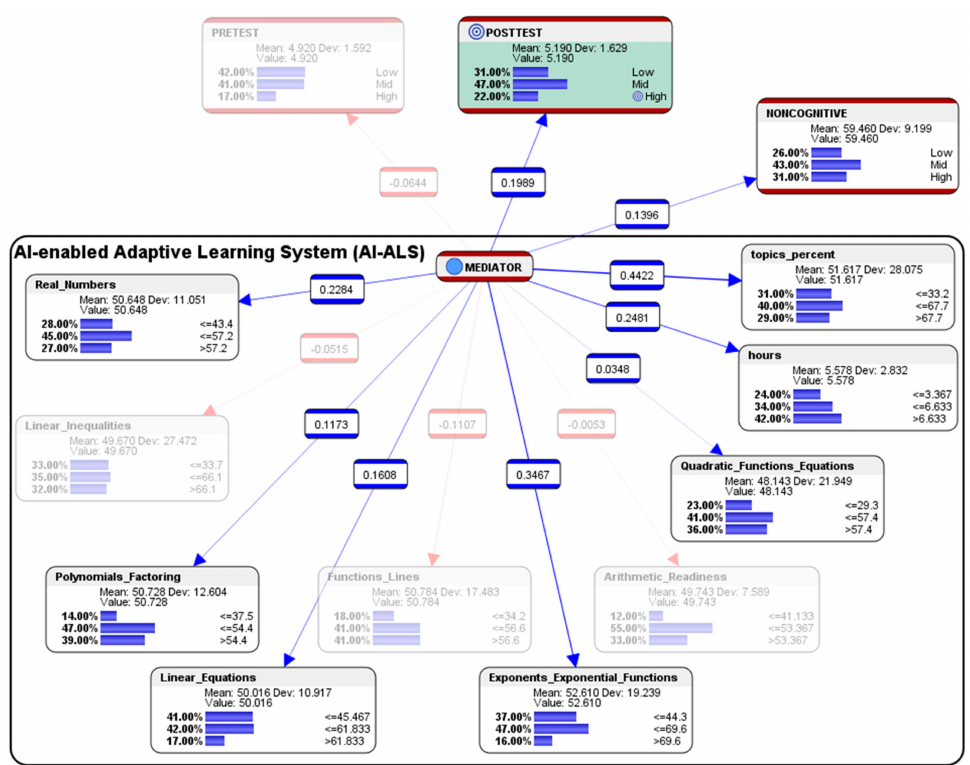
Figure 14. Pearson correlations between the students’ learning progress of the mathematics topics within the AI-ALS and their corresponding performances in the paper-based post-test.